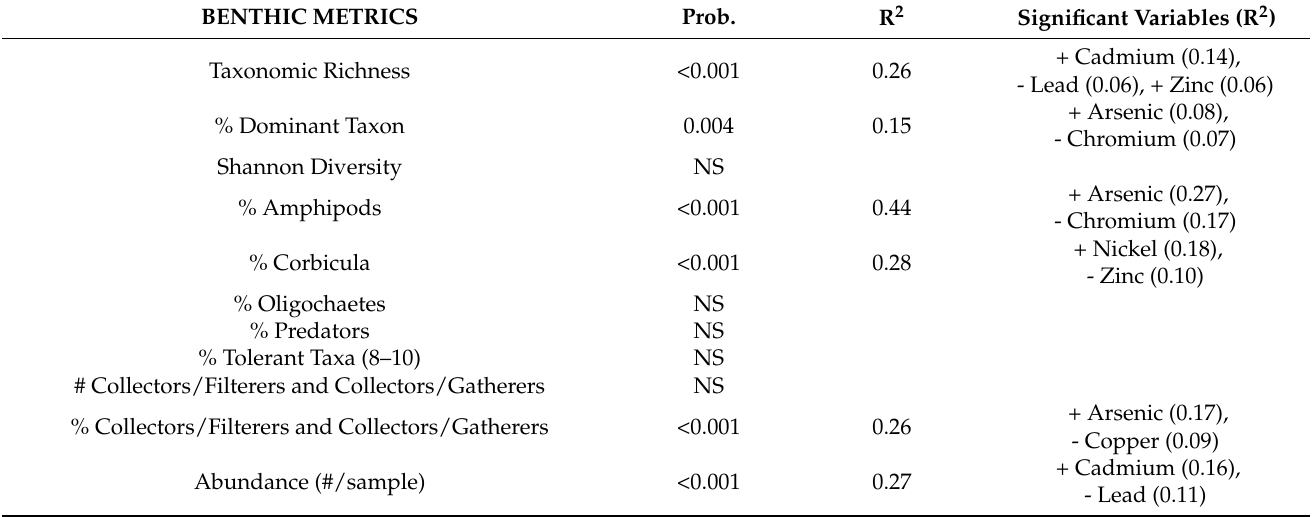
Table 2. Results of the stepwise multiple linear regression models of benthic metrics versus metals in sediments (standardized to toxic units by dividing by TEL values for the metals) for the Cache Slough in the combined 2012, 2013, and 2014 data set. Only variables that were significant at α = 0.01 were included in the models (NS = not significant). The direction of the relationship for each significant variable is indicated (+ = direct; - = inverse), as is the contributed R 2